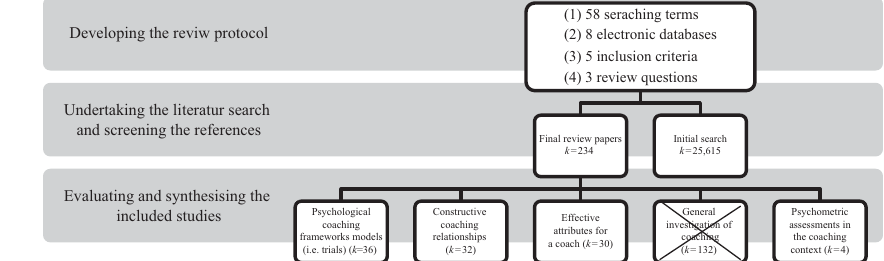
Figure 1. Overview of the review